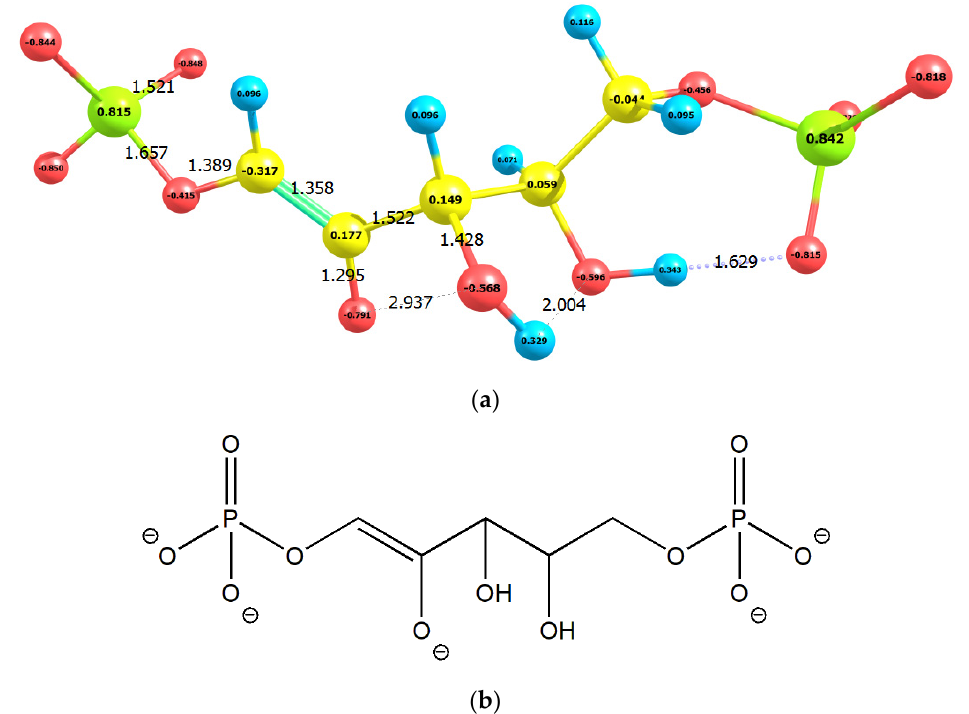
Figure A5. ( a ) The calculated geometric and electronic structure of 1/2-ene(mono/di)olate (1,2-enolate); Q = − 5, M = 1, E 0 = − 46,424.13 eV, G 0 = − 46,421.11 eV. Hessian has negative frequencies: − 135.86, − 98.86 (cm − 1 ). ( b ) The scheme of (Z)-3,4-dihydroxy-2-oxidopent-1-ene-1,5-diyl di- phosphate.